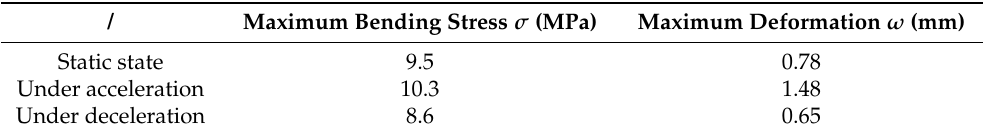
Table 1. The bending stress and deformation of small rail roadway stacker.